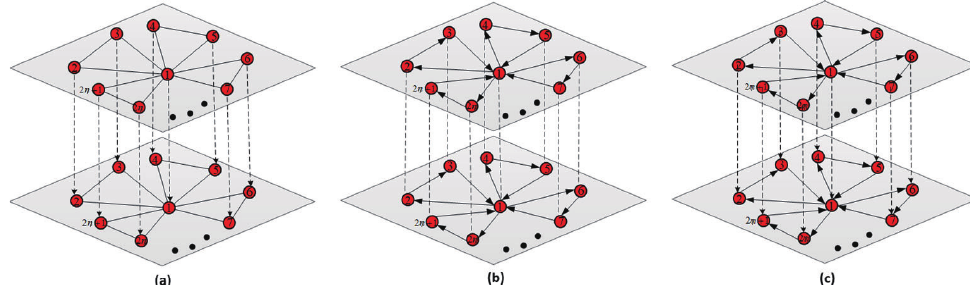
Figure 1. Schematic diagram of multilayer directed Dutch windmill networks. ( a ) Networks-A with two layers; ( b ) Networks-B with two layers; ( c ) Networks-C with two